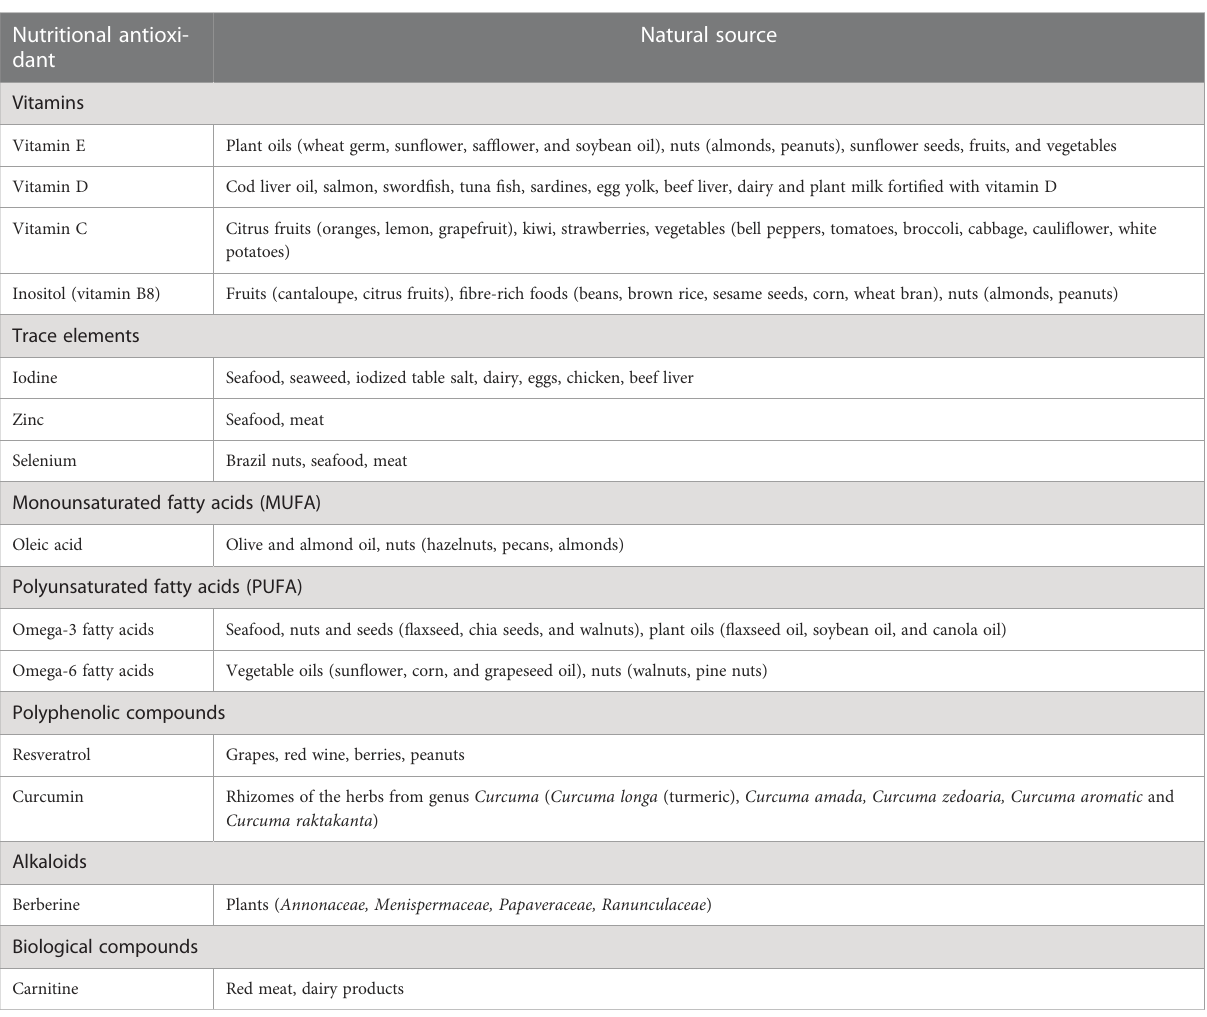
TABLE 2 Classi fi cation of nutritional oxidants with protective roles against oxidative stress in thyroid diseases and their naturally occurring sources. Nutritional antioxi- dant